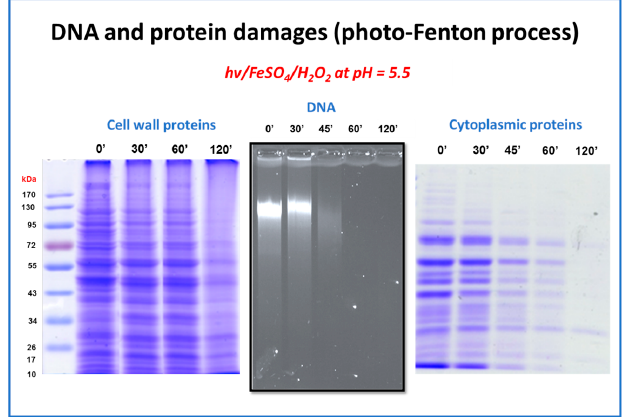
Figure 5. Internal and external damages during Saccharomyces cerevisiae inactivation by the photo-Fenton process at near-neutral pH. The panels indicate the external and two types of internal damage inflicted to the model yeast pathogen: cell wall proteins, genome and cytoplasmic proteins, respectively.